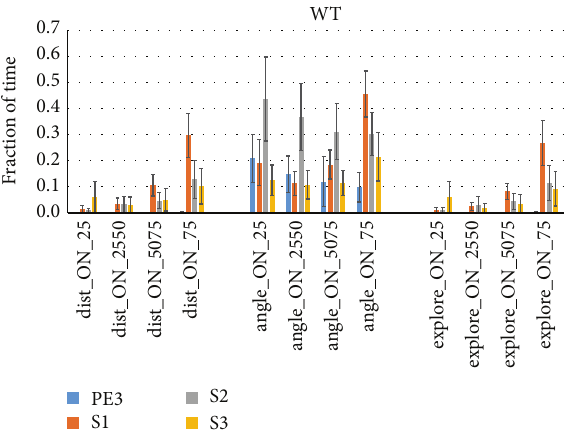
Figure 7: Sniff rate quartiles discriminate exploration time based on the proximity criterion. The same as Figure 6, but here the fraction of time the mouse spent sniffing at each quartile’s sniff rate while fulfilling the < 2 cm nose proximity criterion (left), the < 20 ∘ head orientation criterion (middle) or both criteria was determined. WT mice ( 𝑛 = 7 ) were in close proximity to the odor for 30% of the time they sniffed fast (dist ON 75) during S1 trials but 13% or less during other trial types (i.e., 87% or more of the time they sniffed at high rate they were > 2cm from the odorant during PE3, S2, or S3). For orientation the results were not as trial type specific or sniff rate specific (especially S2 at angle ON 25: 44% of time oriented to odor during slow (lowest quartile) sniff rates). The orientation criterion does not appear to add to the exploration time fraction as determined by nose proximity (dist ON), as explore ON is quite similar to dist ON. FUS KO mice showed similar results (not shown).